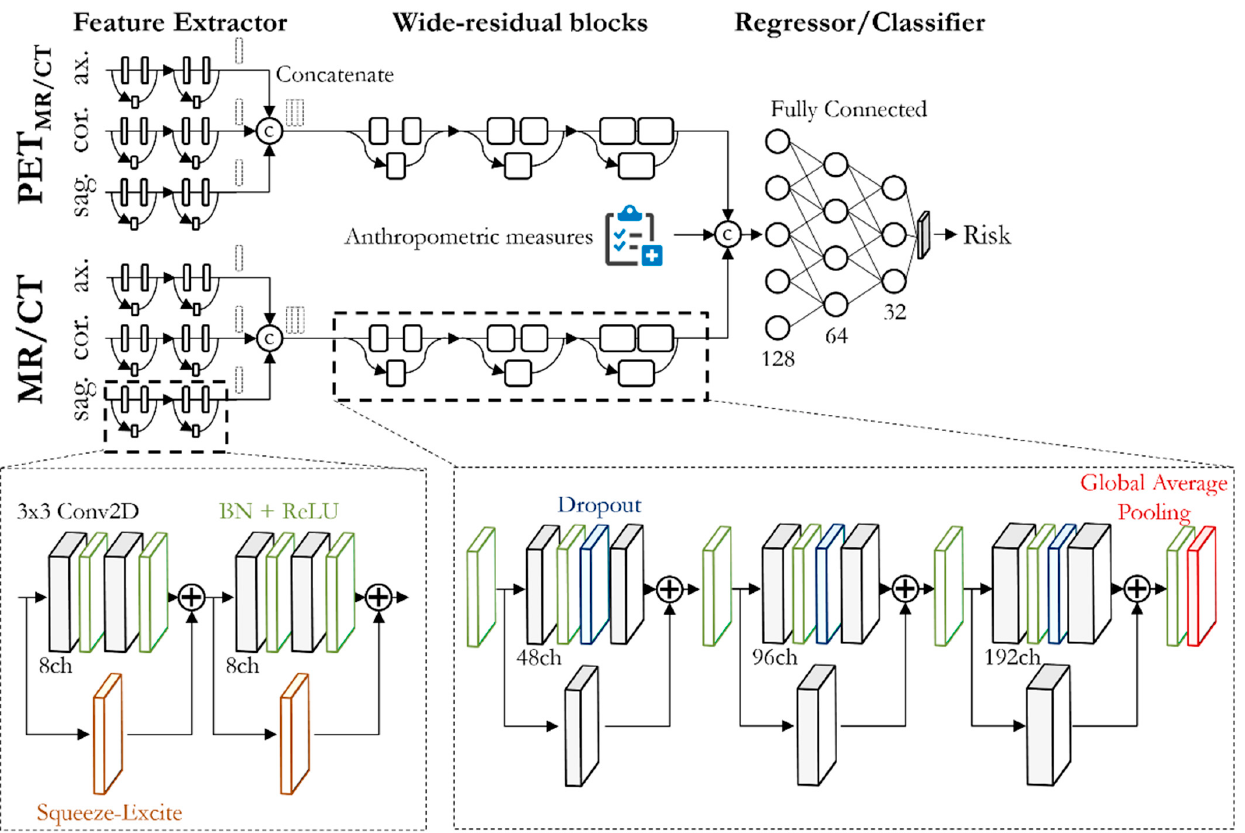
Figure 1. Overview of the multiparametric image analysis employing an AI-assisted evaluation and clinical evaluation to investigate the parametric dependency on treatment planning. An AI-assisted multiparametric evaluation was performed on automatically segmented (training) and manually selected (testing) target lesions (largest SULpeak and diameter) to support the treatment decision by grouping patients into low- and high-risk groups for unsuccessful immunotherapy treatment.